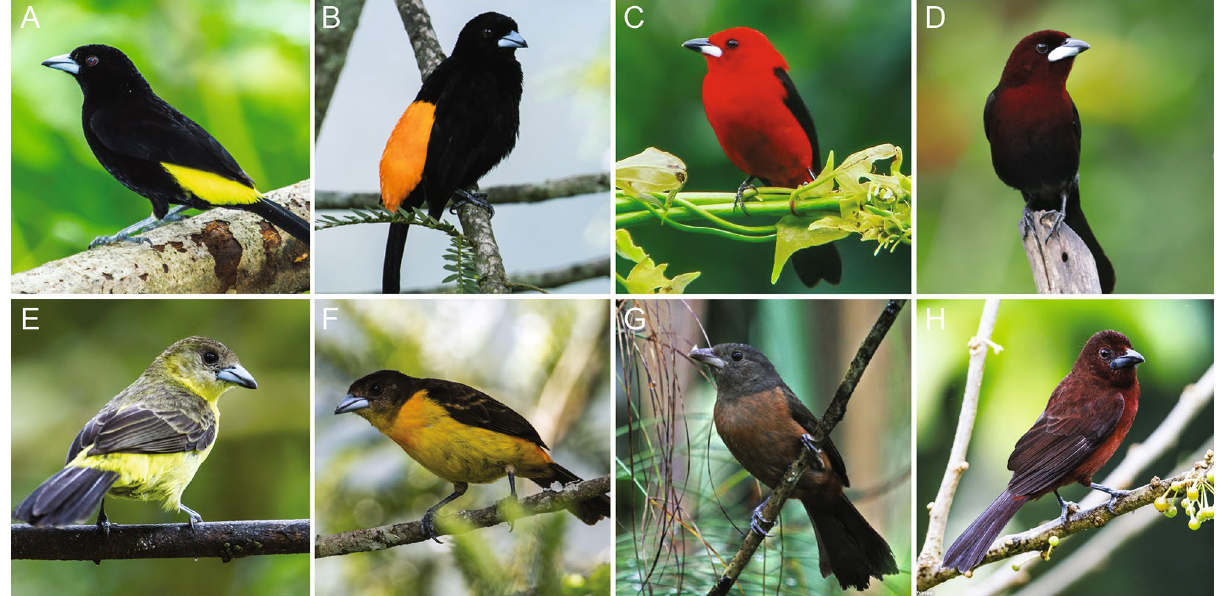
Figure 1. Male Ramphocelus tanagers (top row) have more striking carotenoid-based coloration than females (bottom row). ( A ) R. flammigerus icteronotus male with vivid yellow and deep black plumage. ( B )